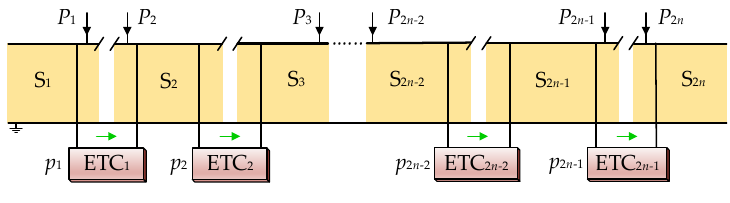
Figure 5. The simplified system and its power description.